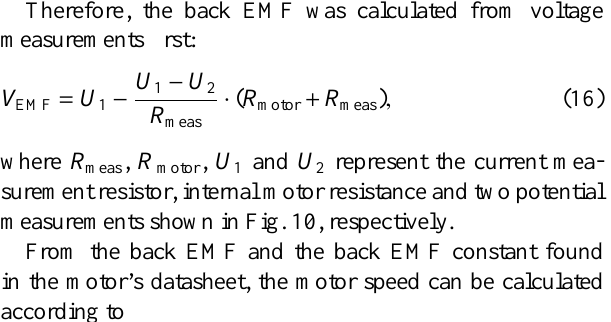
Figure 11. Desired transient responce of the accelerated pendulum.